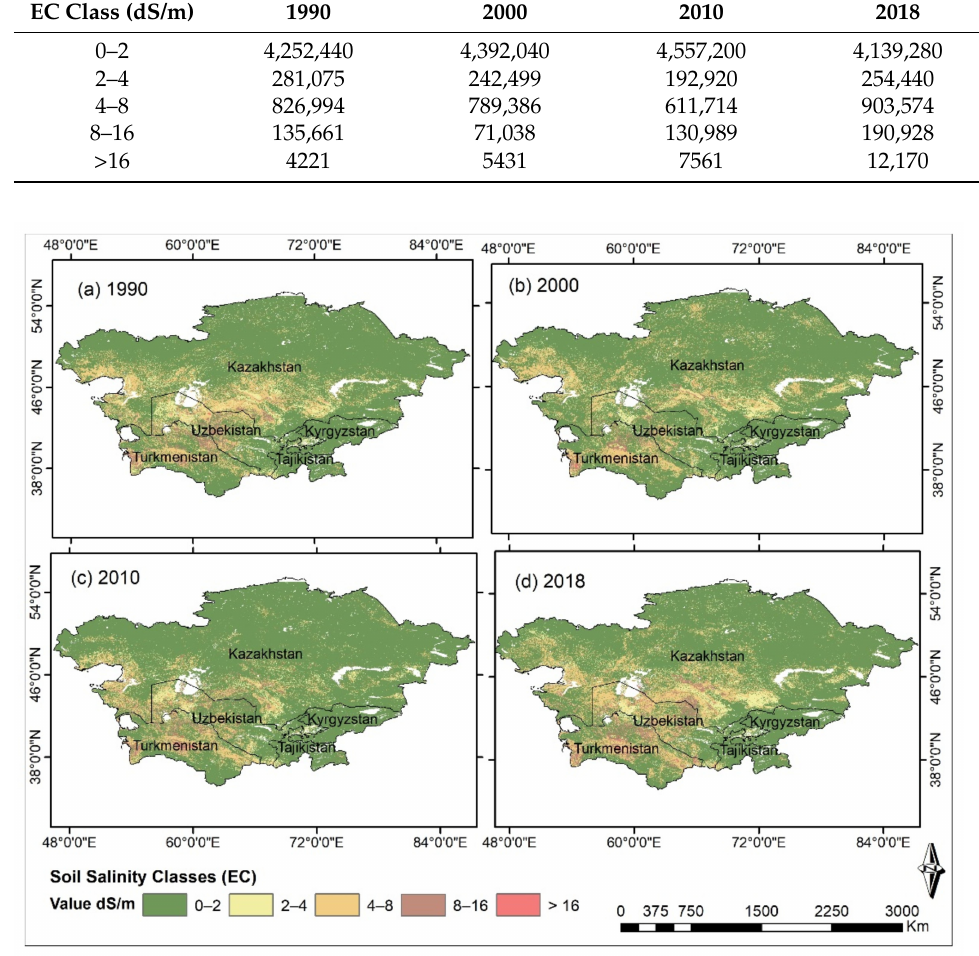
Figure 3. Soil EC distributions across Central Asia in 1990, 2000, 2015, and